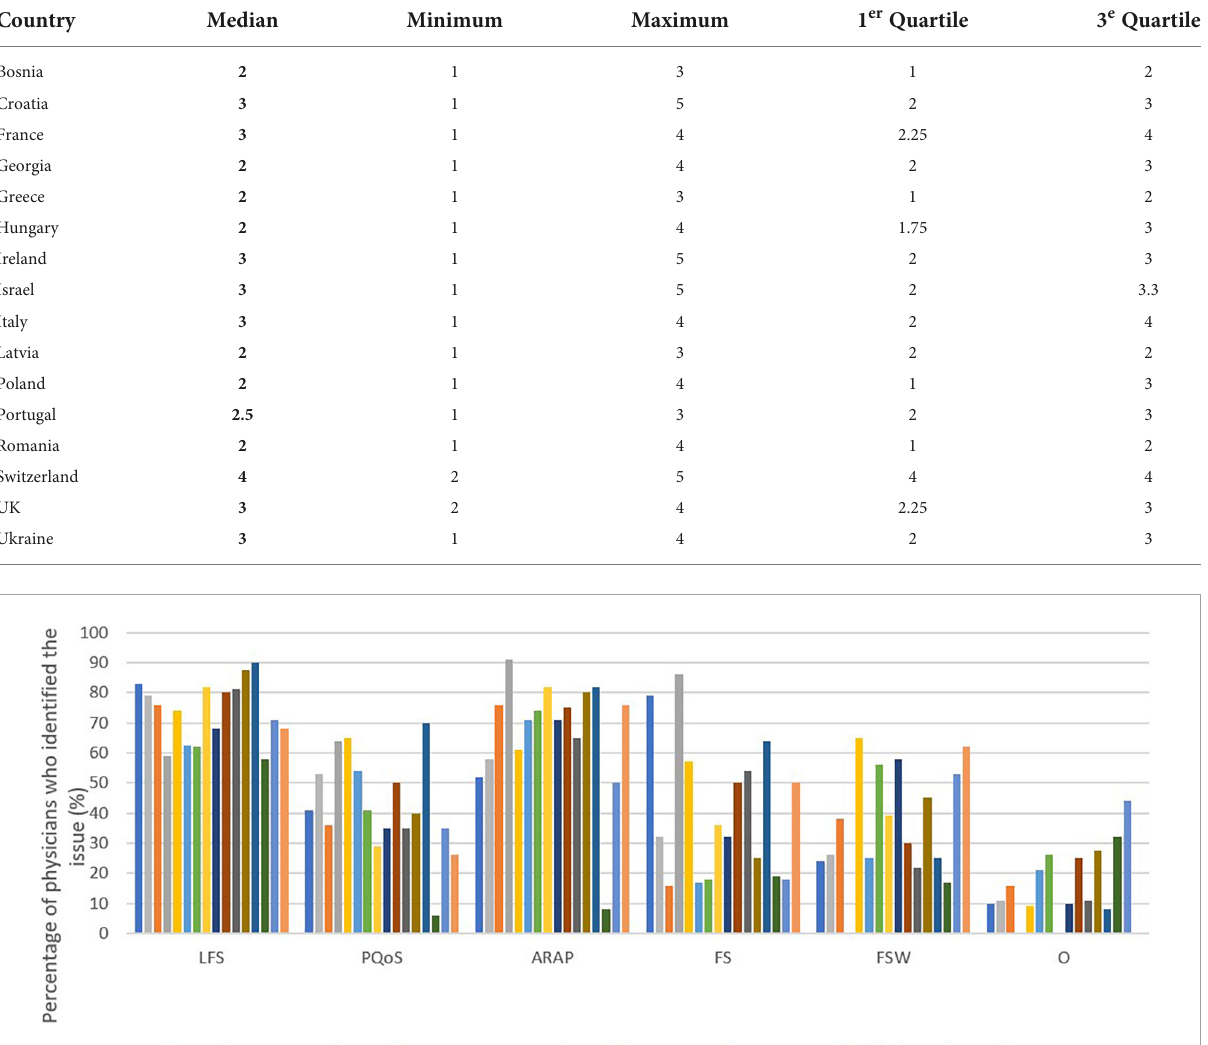
TABLE 2 Assessment of the quality of care by general practitioners by country. Country Median Minimum Maximum